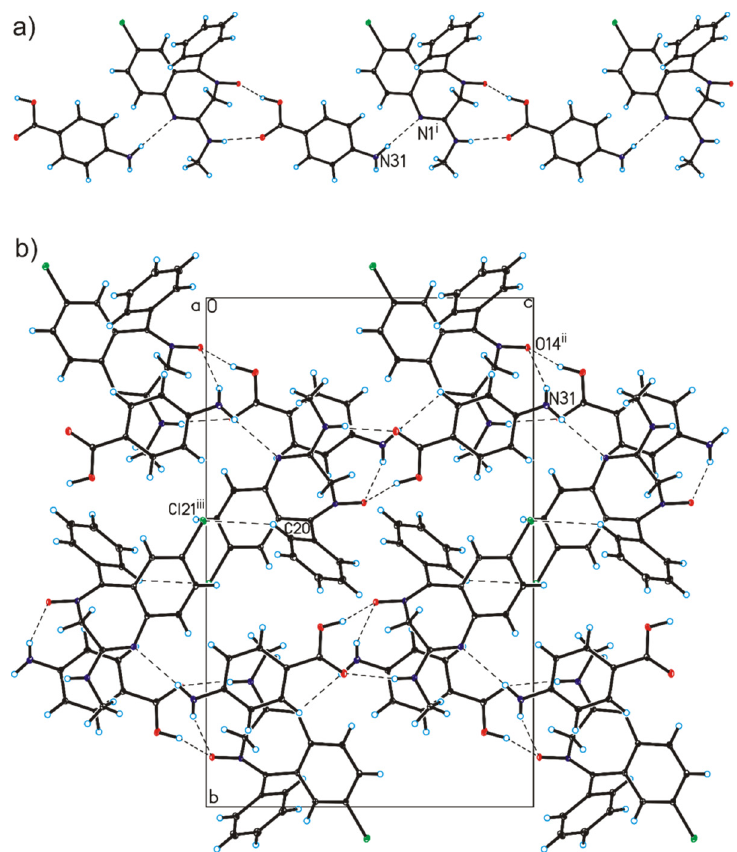
Figure 6. ( a ) Chains formed by chlordiazepoxide and p -aminobenzoic acid molecules in the co-crystals. ( b ) Crystal packing of chlordiazepoxide co-crystals with p -aminobenzoic acid viewed along the a -axis (hydrogen bonds are represented by dashed lines; symmetry codes: (i) x, y, 1 + z; (ii) − 1 + z; (iii) 2 − x, 1 − y, − z. 1 2